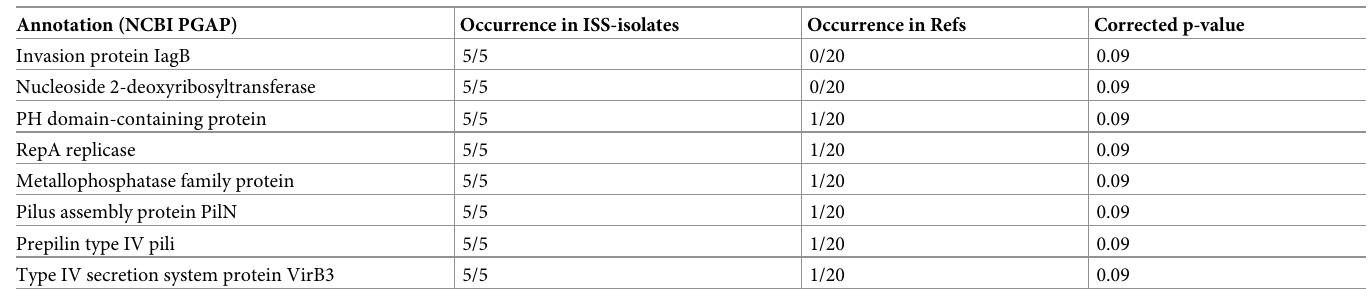
Table 2. ISS-derived B . contaminans enriched functions as compared to references.